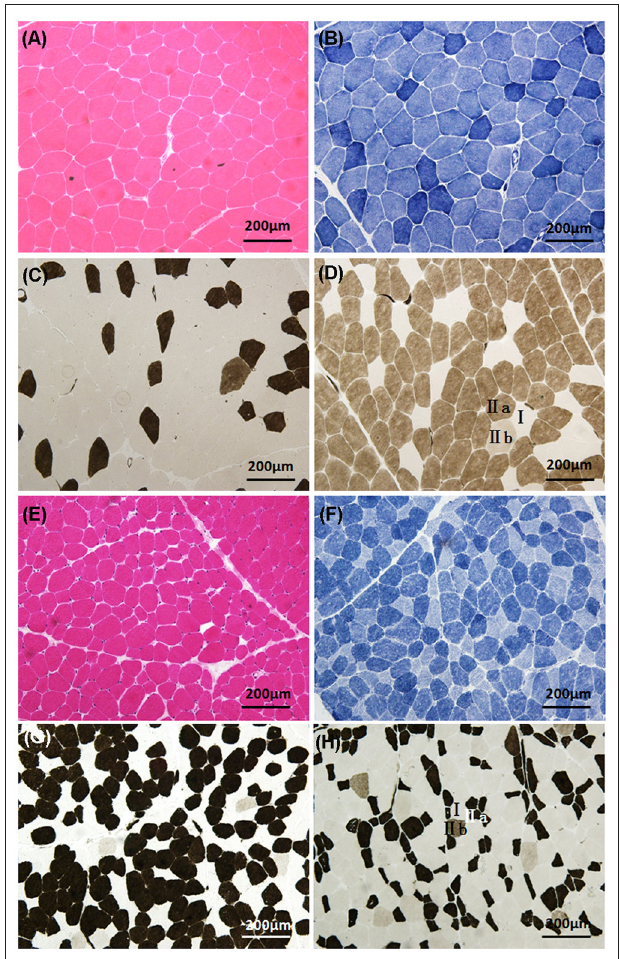
FIGURE 2 | Histologic characteristics of non-dystrophic myotonias. Patient 5 (myotonia congenita): (A) (HE) demonstrates the variation of fiber diameter; (B) (NADH-TR) shows that the enzyme activity was normal; (C,D) (ATPase, pH 4.5 and 10.1) demonstrate the predominance of type IIa fibers, atrophy of type I fibers, and reduction of type IIb fibers. Patient 20 (paramyotonia congenita): (E) (HE) demonstrates the variation of fiber diameter; (F) (NADH-TR) shows that the enzyme activities were focally decreased in some fibers; (G,H) (ATPase, pH 4.5 and 10.1) demonstrate the predominance of type I fibers, atrophy of type IIa fibers, and reduction of type IIb